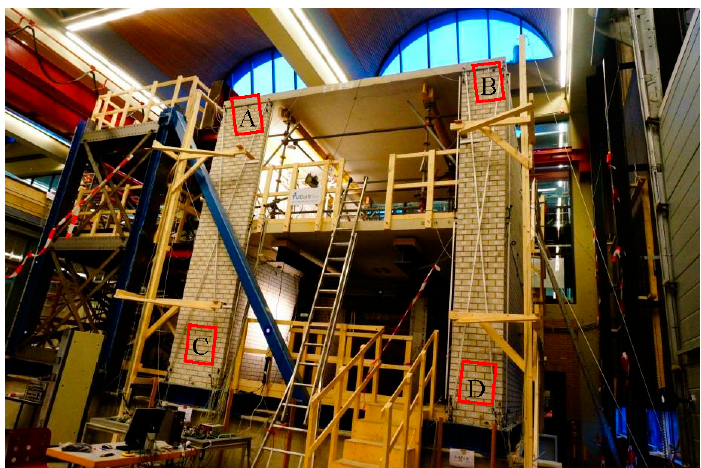
Figure 3. Station view of the seismic testing house.